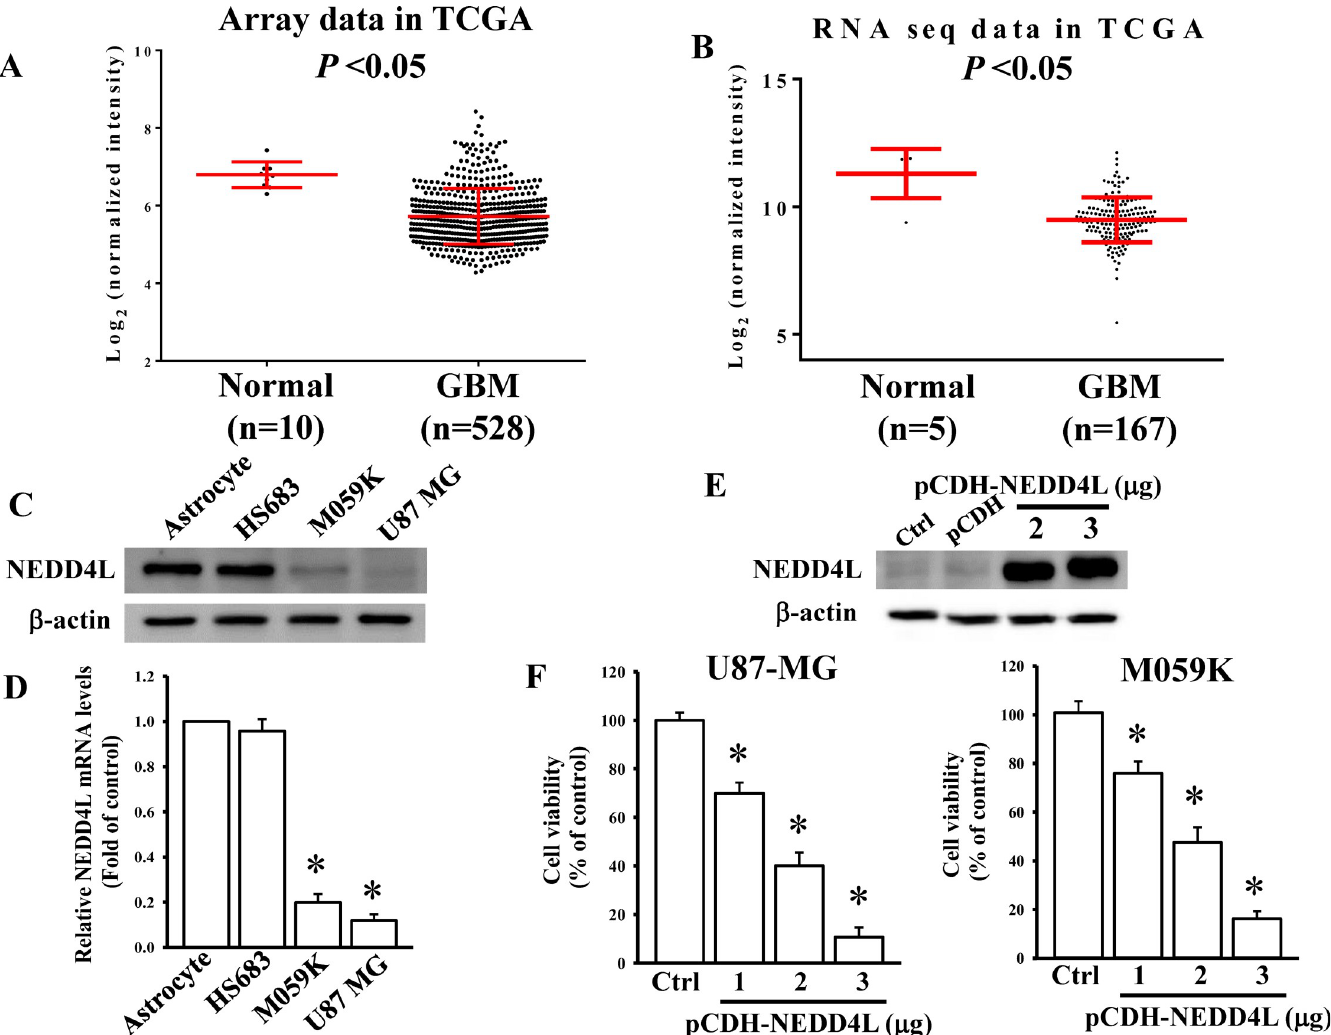
Fig 4. Overexpression of NEDD4L levels induces glioma cell death. (A and B) Relative NEDD4L expression levels in glioblastoma multiforme (GBM) patients compared to normal control groups from the microarray and RNA sequencing (RNA Seq) data of TCGA database. Detection of endogenous NEDD4L protein (C) and mRNA (D) levels in human normal astrocytes and three different glioma cell lines. Endogenous NEDD4L protein and mRNA levels were respectively measured by an immunoblotting assay and a real-time PCR. β -Actin and GAPDH levels were used as internal controls. Data are the mean ± SD of three independent experiments. � p < 0.05. (E) Detection of NEDD4L levels in NEDD4L-overexpressing cells. (F) Overexpression of NEDD4L reduced glioma cell viability. After cells were transfected with the indicated doses of NEDD4L cDNA-containing plasmids for 24 h, NEDD4L protein levels were measured by immunoblotting assays. Cell viability was measured by an MTT assay. Data are the mean ± SD of three independent experiments. � p < 0.05.